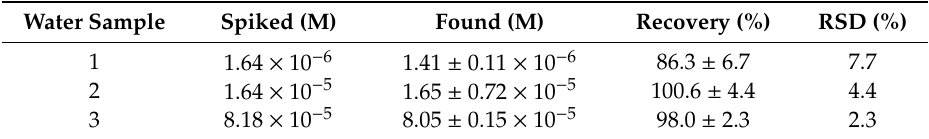
Table 1. Percentage recoveries and relative standard deviation (RSD) of the detection of New Red spiked in water samples (mean ± SD, N = 3).